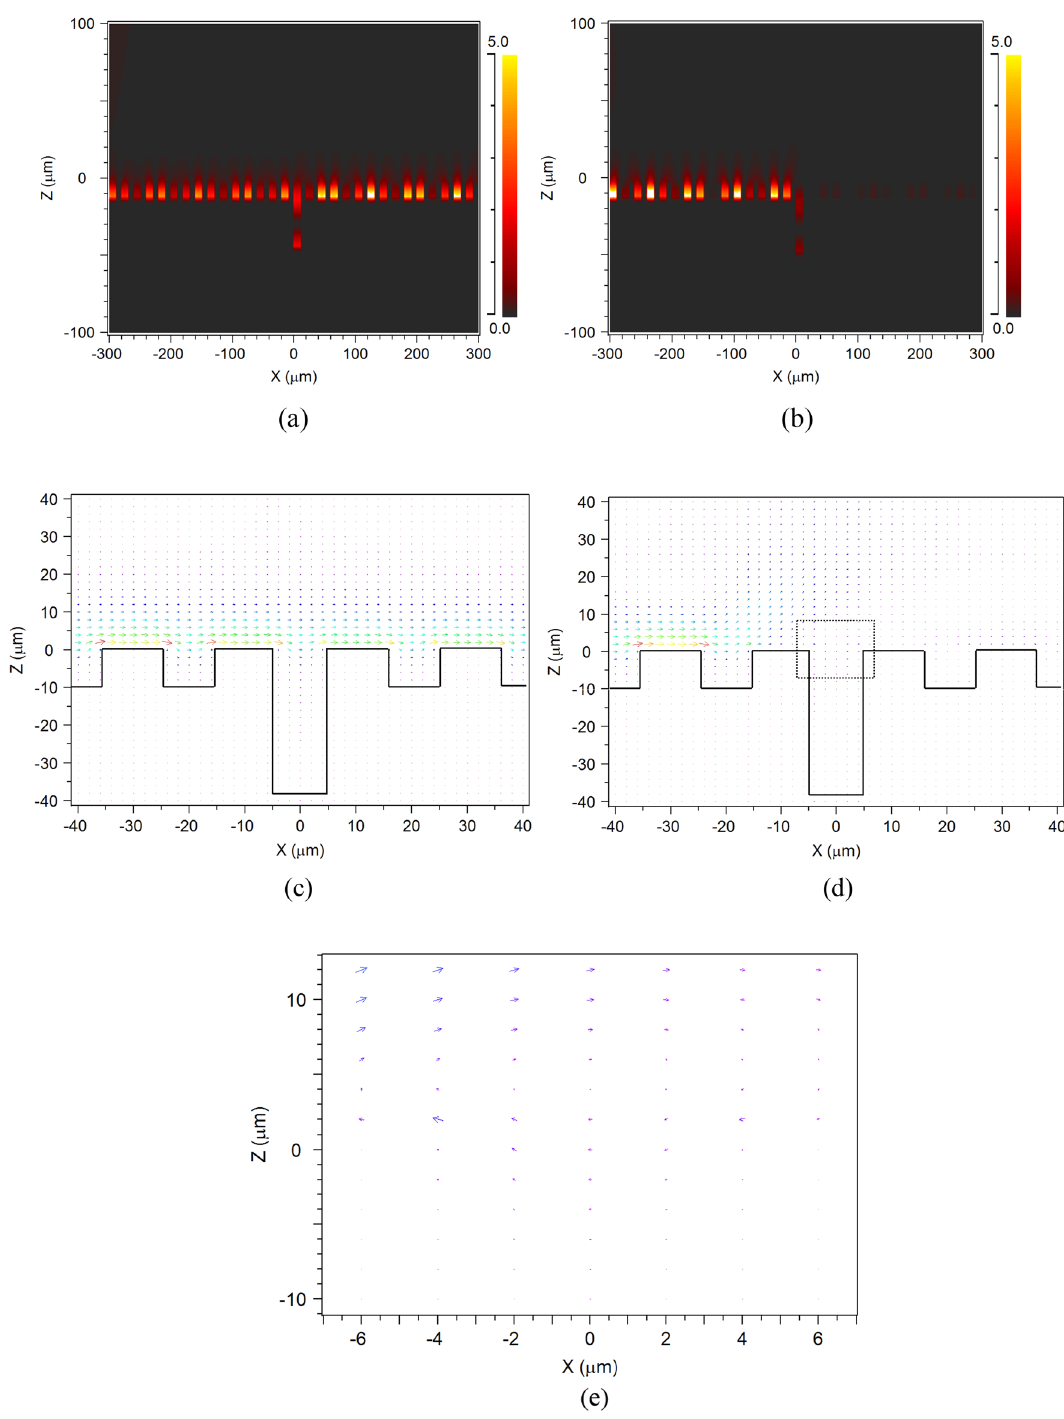
Figure 4. Two-dimensional field distribution of EM wave with a frequency of 3.75 THz obtained through grating with a single obstructed groove of varying depth (Δ n = 0). The increased depths of the obstructed groove are Δ d = 32 μm ( a ), Δ d = 36 μm ( b ). The Poynting vector distribution near the single obstructed groove with Δ d = 32 μm ( c ), Δ d = 36 μm ( d ). The Poynting vector distribution in the enlarged region marked by black dotted line in center of ( d ) is shown in ( e